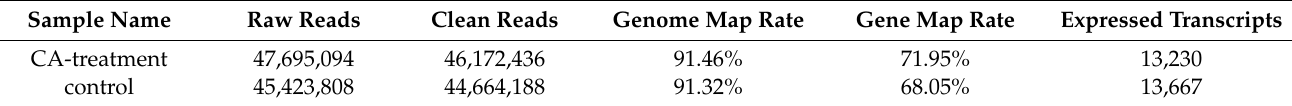
Figure 5. Histogram of gene ontology (GO) classification ( A ) and Scatter diagram of KEGG pathway enrichment ( B ). Table 1. Summary of sequences analysis of sample of treated with CA and control.